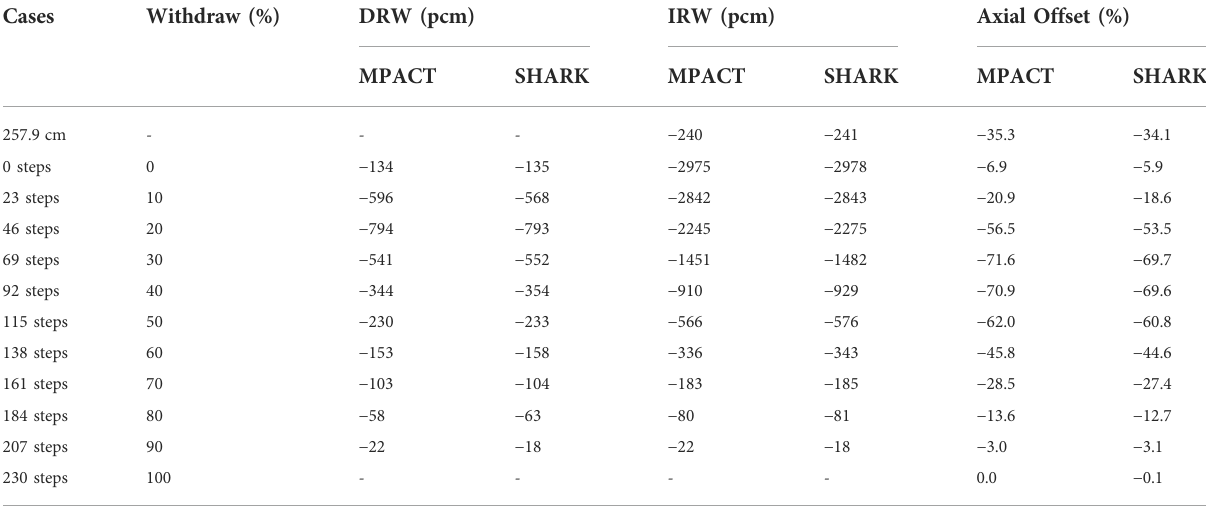
TABLE 1 Calculation results for the VERA #4